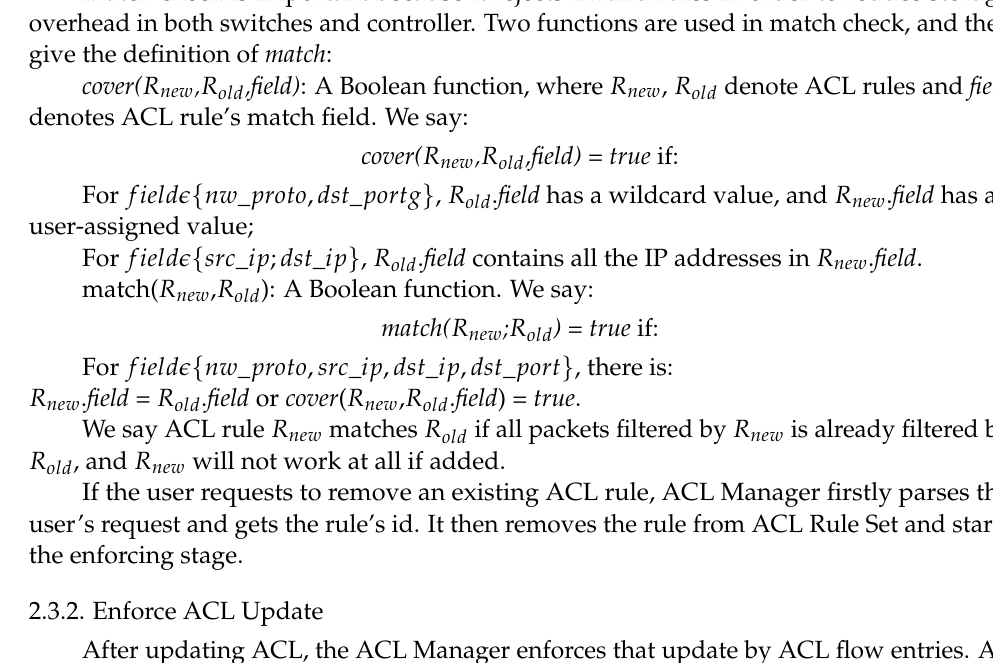
Figure 3. Abstract network view and Accessing Pair (AP)